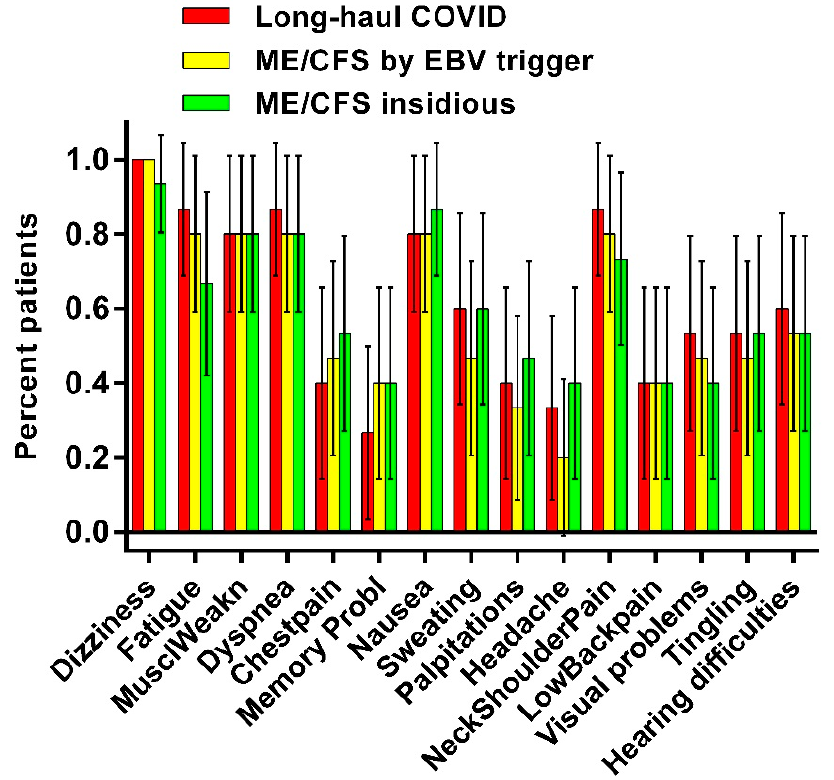
Figure 2. Frequencies of orthostatic intolerance complaints after tilting, as assessed by a questionnaire, in long-haul COVID cases (red), in ME/CFS controls triggered by EBV (yellow) and in ME/CFS controls with an insidious onset